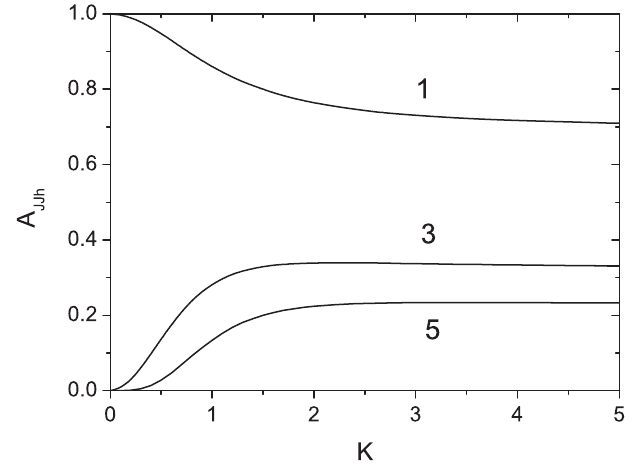
FIG. 1. Coupling factors for the 1st, 3rd, and 5th harmonics (denoted with 1, 3, and 5, correspondingly) versus rms undulator parameter.